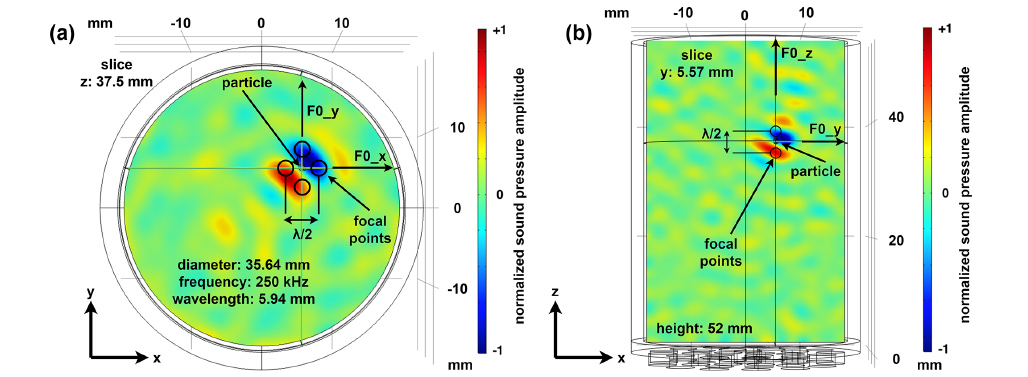
Figure 5. Simulation example at 250kHz: intensity plot of the acoustic pressure field of the bottle trap (a) in the x – y and (b) in the x – z plane in a cylindrical vessel with a time reversal mirror composed of 24 piezoceramic transducers attached to the